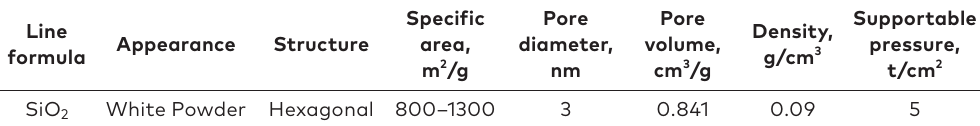
Table 2. Properties of LUS-1 (Bonneviot et al.,